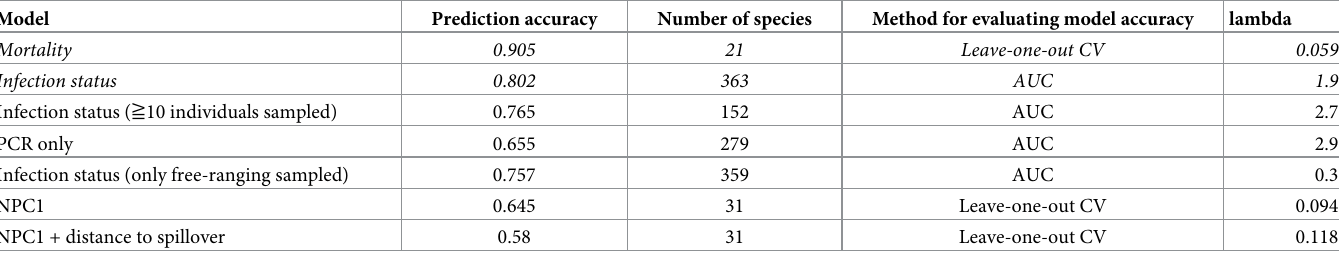
Table 1. Summary of all models predicting mortality and infection status considered. For each model, table provides prediction accuracy, number of species to which model was fit, method for evaluating model accuracy and lambda parameter used in ridge regression. The two models used to predict the infection characteristics of Afri- can mammals in Fig 1 are